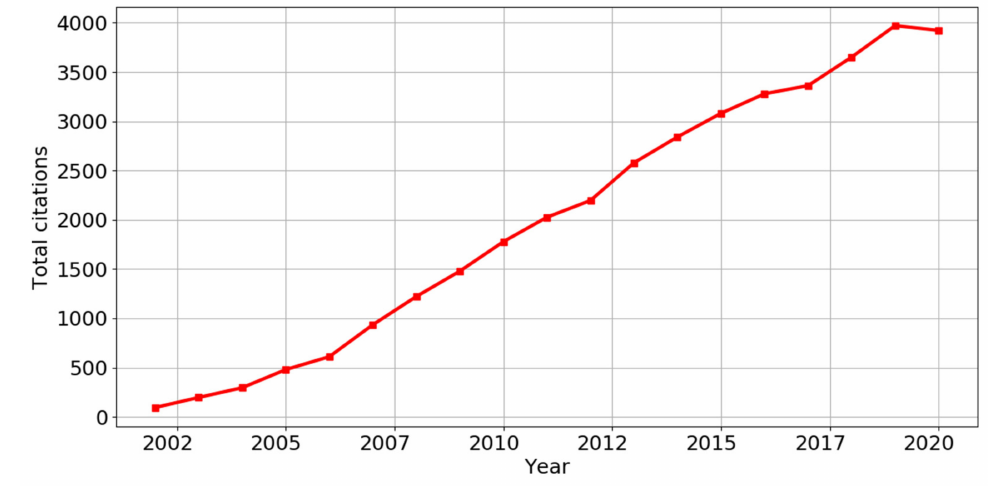
Figure 6. Total citations of original NSGA-II papers over the